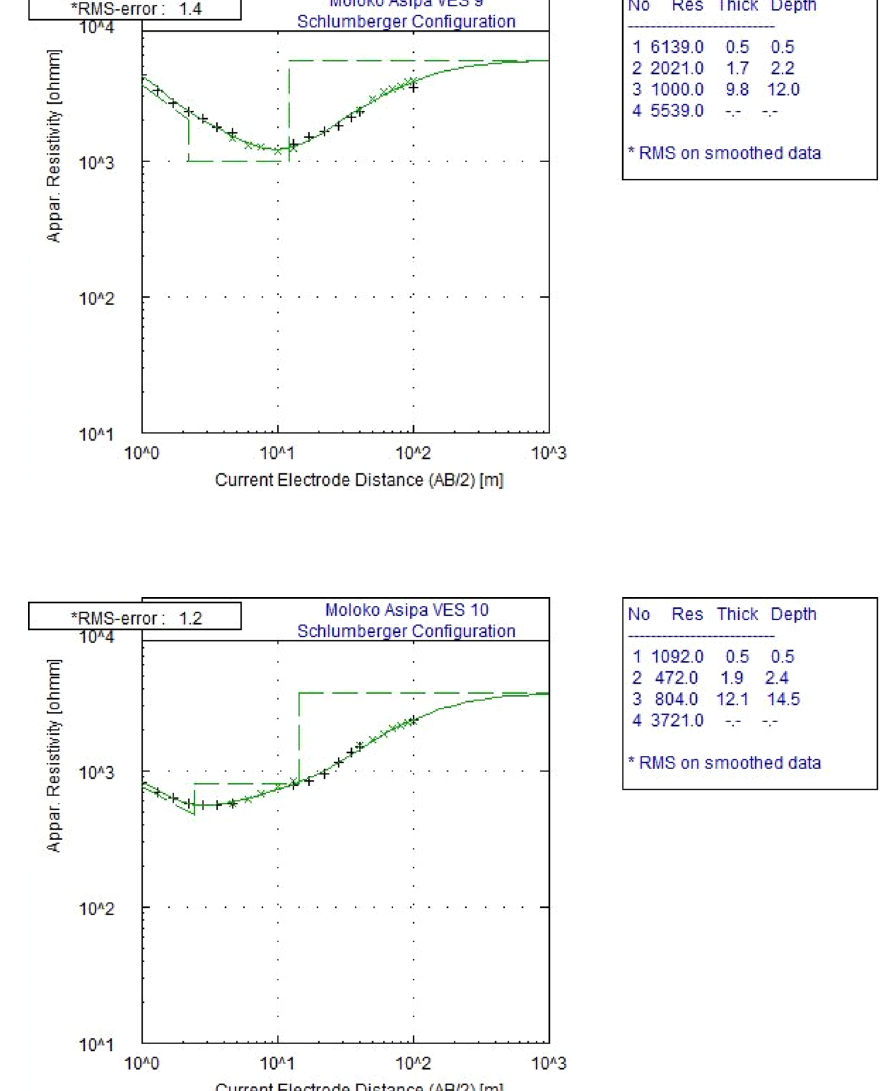
Fig. 18 Layer model interpreta- tion for VES 8